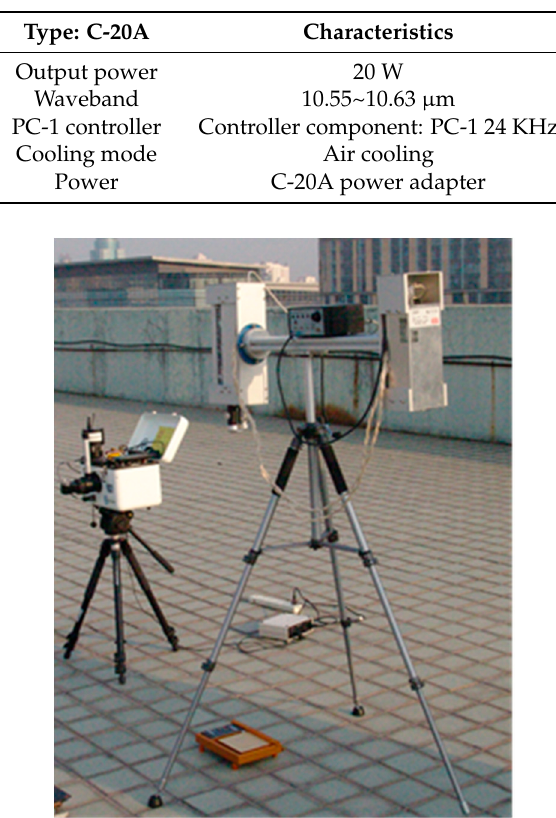
Table 2. The characteristics of the CO 2 laser used in the study.